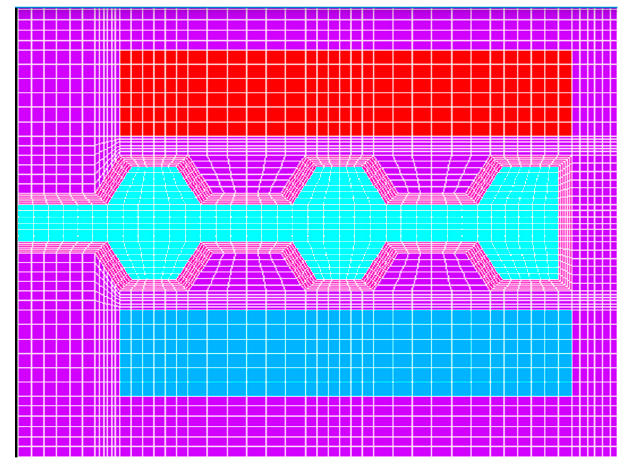
Figure 5. Finite element model for magnetic analysis of the rotary MR brakes.